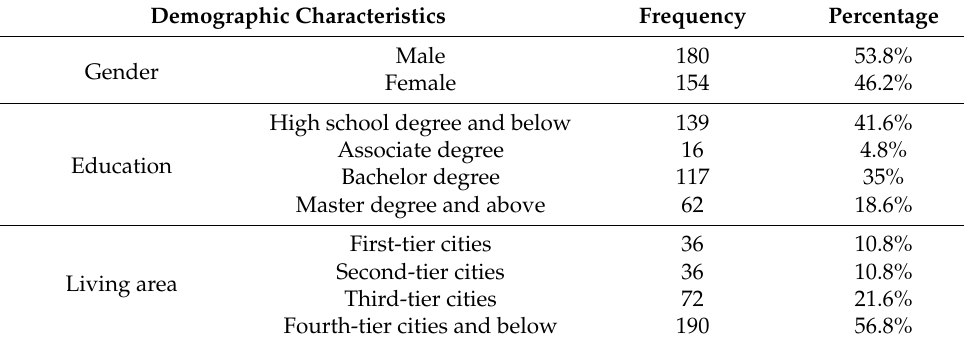
Table 2. Sample demographic